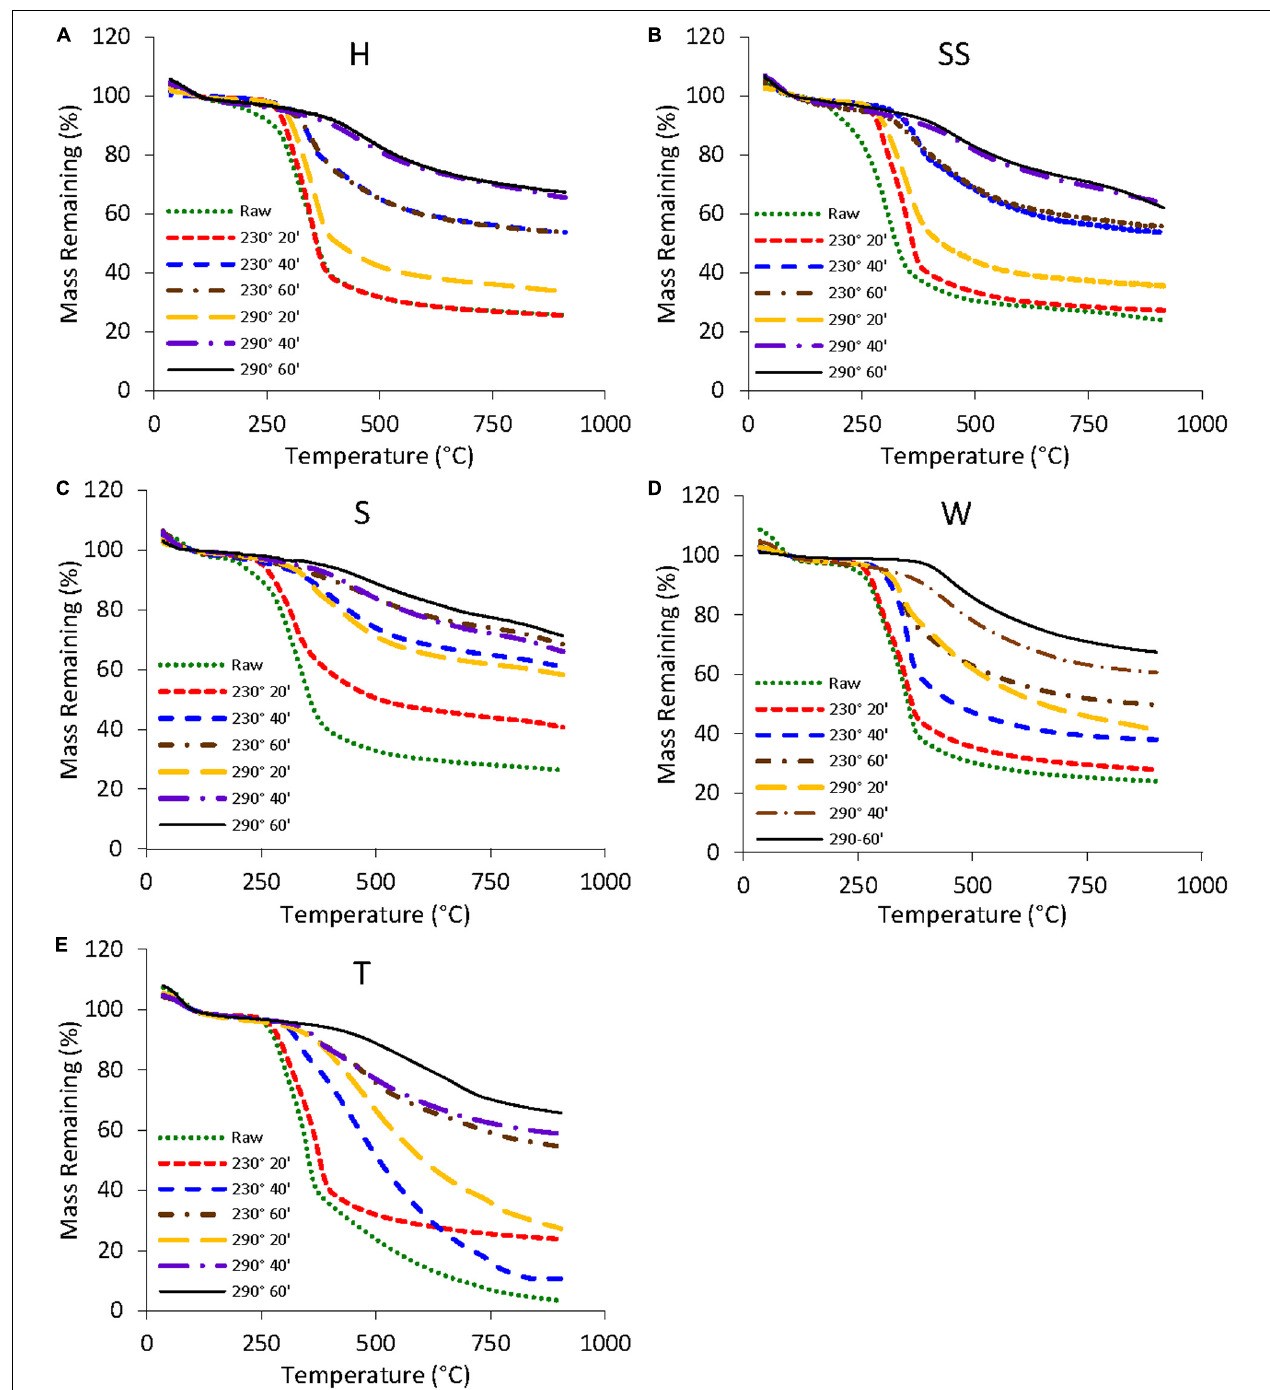
FIGURE 6 | TG curves for: (A) hard (H), (B) semi-soft (SS), and (C) soft (S) almond shells, (D) walnut (W) at torrefaction conditions, and (E) almond twigs (T) shells of raw, 230 and 290 ◦ C and residence time of 20, 40, and 60min.